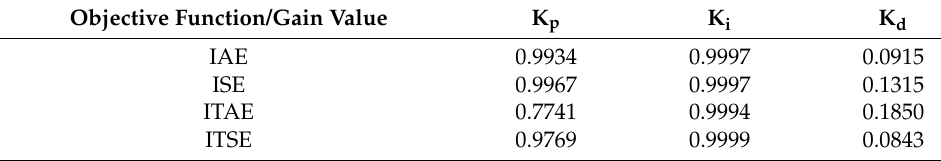
Table 3. Gain values of the PSO-optimized PID